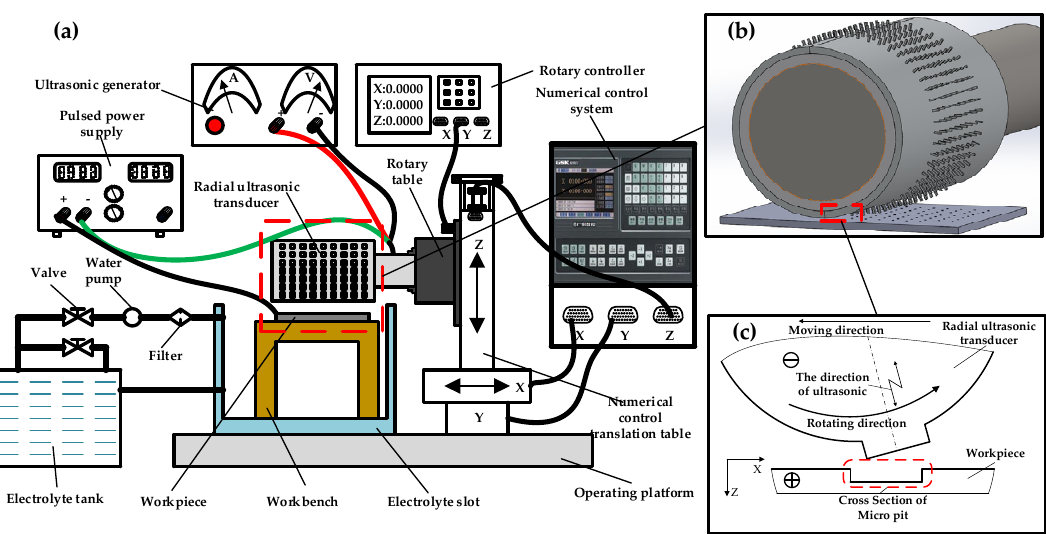
Figure 1. Schematic of ( a ) the proposed radial ultrasonic rolling electrochemical micromachining (RUR-EMM) system; ( b ) machining process and ( c ) machining principle.